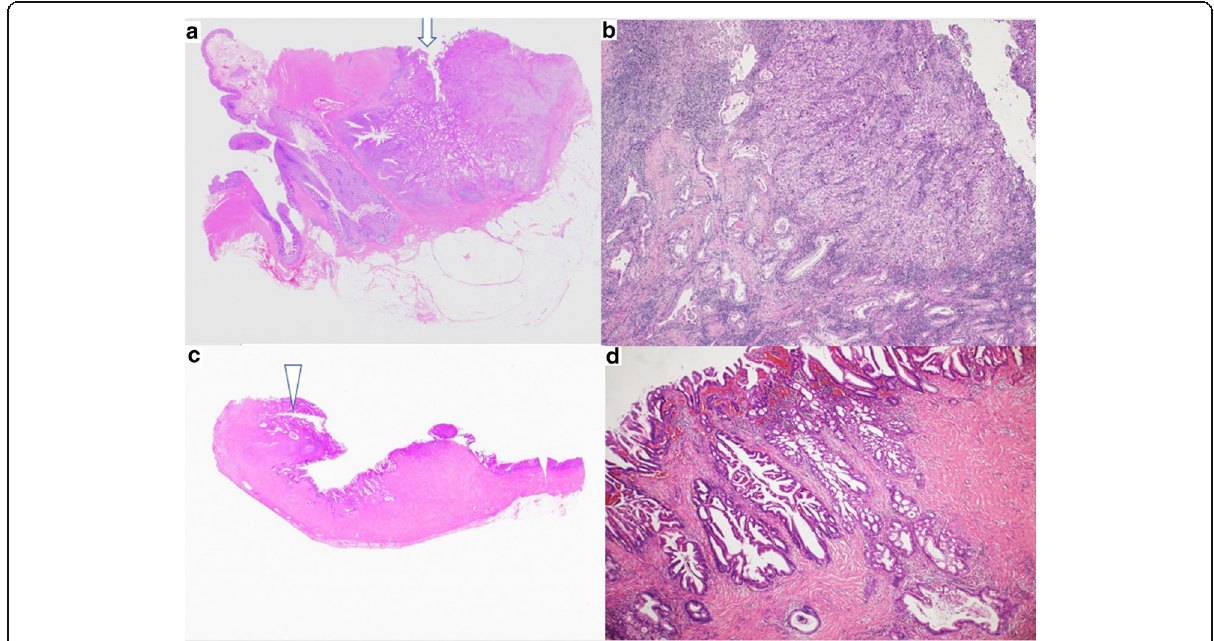
Fig. 5 a The pathology of the proximal lesion within diverticula revealed moderately differentiated adenocarcinomas (arrow). b Low power view of the same lesion shown in ( a ). c The distal lesion revealed moderately differentiated adenocarcinoma (arrowhead). d Low power view of the same lesion shown in ( c